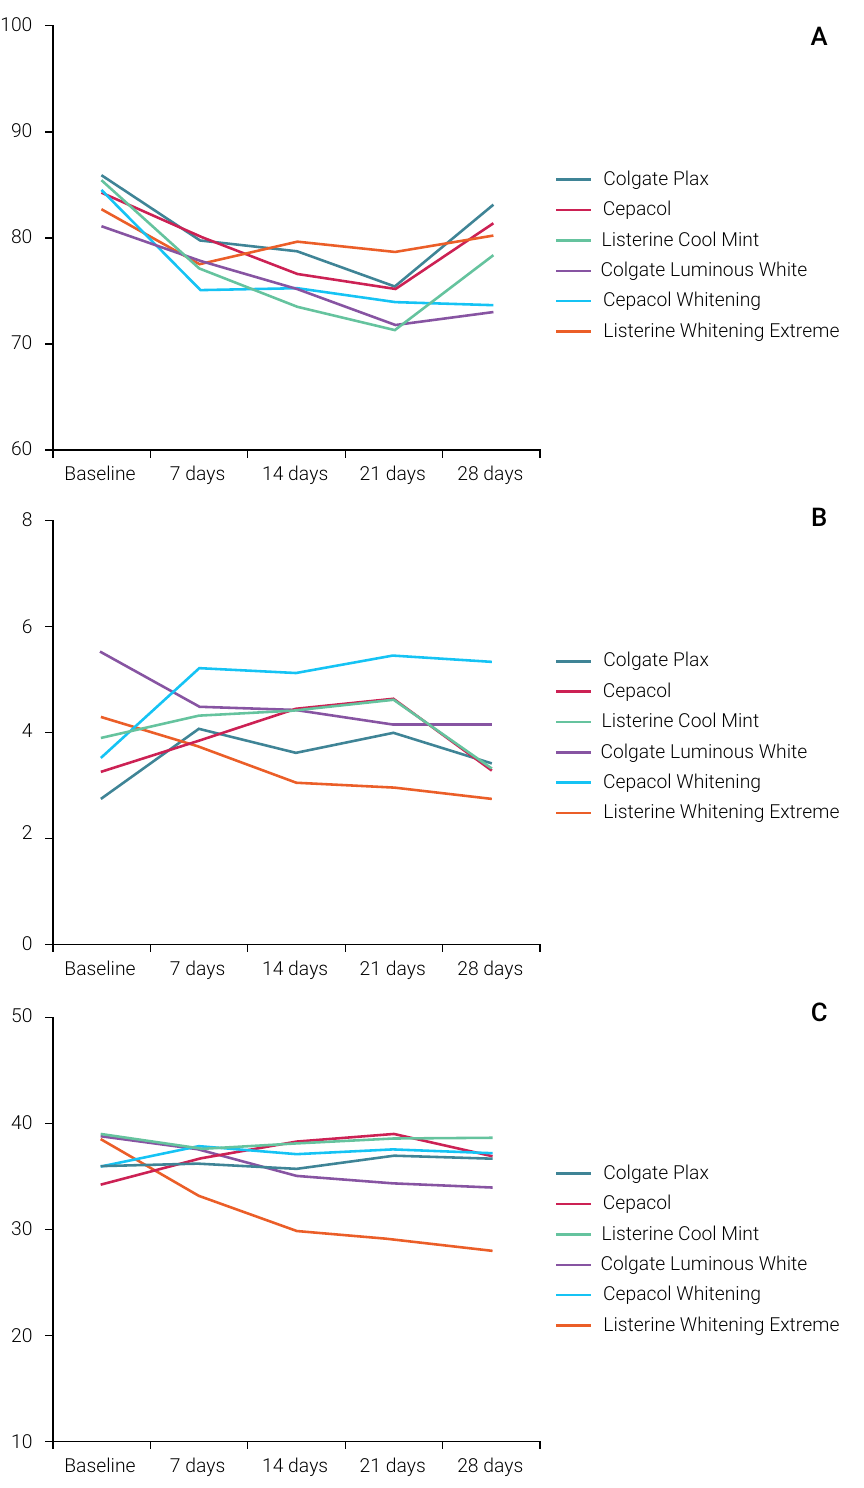
Figure 2. Behavior of L* (A), a* (B) and b* (C) parameters, respectively, throughout the